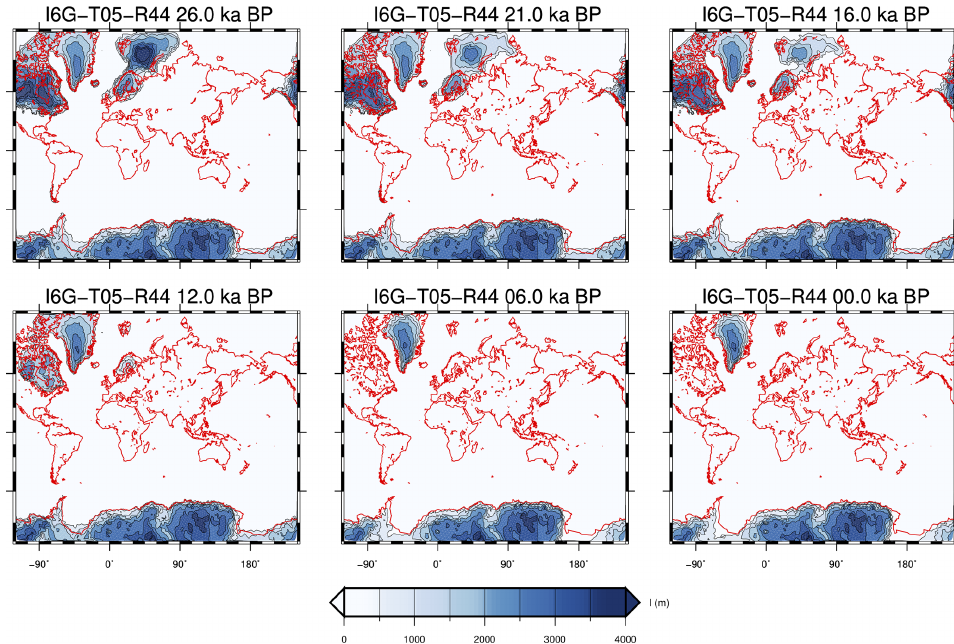
Figure 1. Ice distribution according to model I6G-T05-R44, at six different epochs since 26ka. The maps are obtained by direct triangulation of the pixelized ice thickness data using the GMT program pscontour . This and the following figures are drawn using GMT scripts adapted from those which are available in the output folders of SELEN 4 after execution.